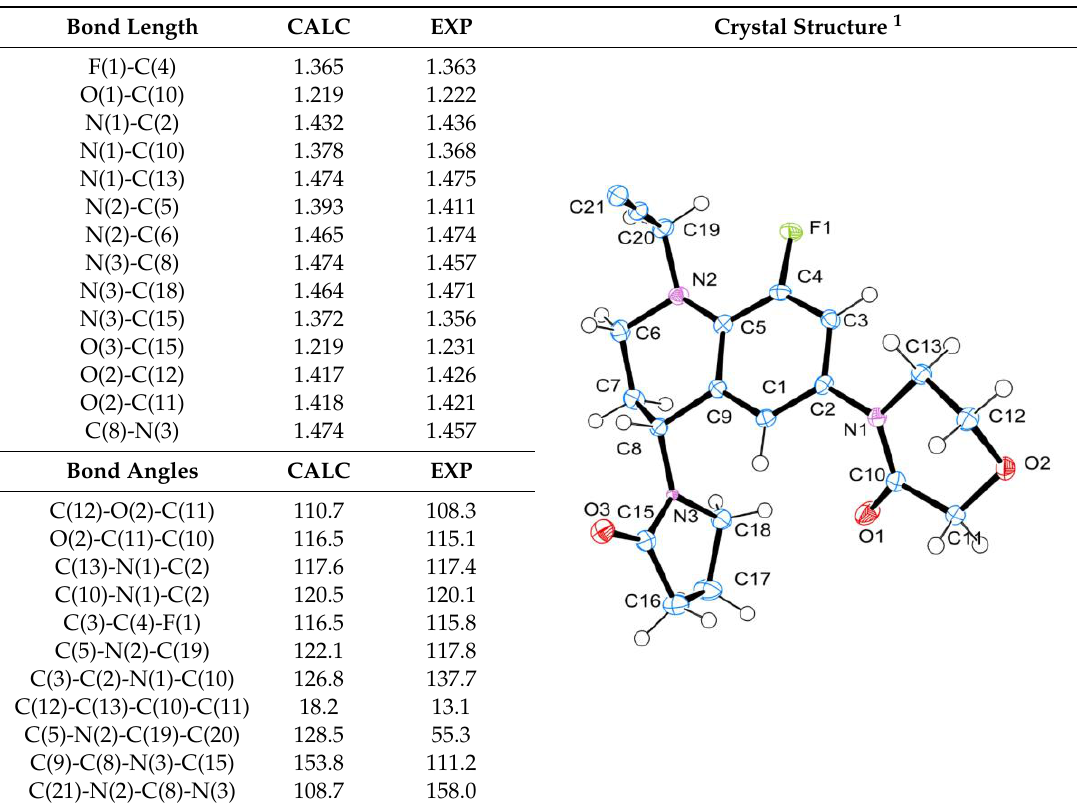
Table 7. Selected bond lengths and angles for molecule 20 .